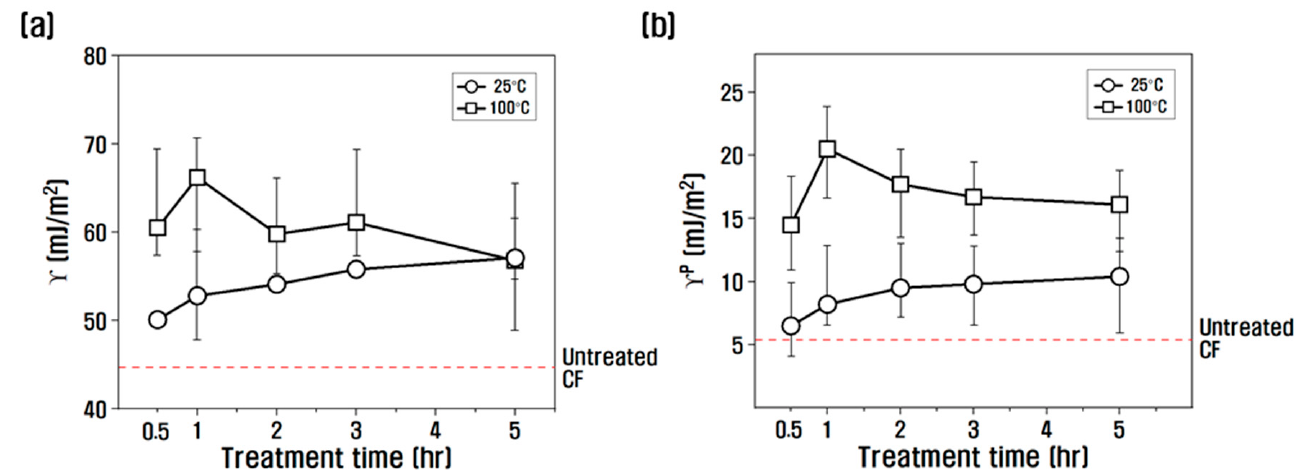
Figure 6. Variation of ( a ) surface free energy and ( b ) polar surface energy of chemical treatment on carbon fibers. carbon fibers.